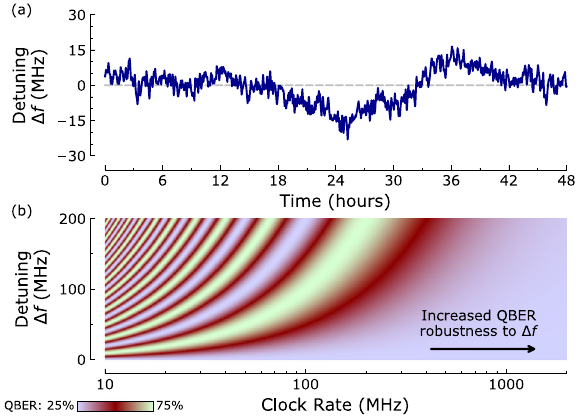
Fig. 3 Laser detuning analysis. a Experimental time-varying spectral detuning Δ f between Alice ’ s and Bob ’ s free-running DFB lasers. b Computed X -basis QBER arising from phase error as a function of detuning and clock rate (assuming equally spaced time bins), showing that a higher clock rate permits greater spectral detuning without signi fi cant QBER increase.